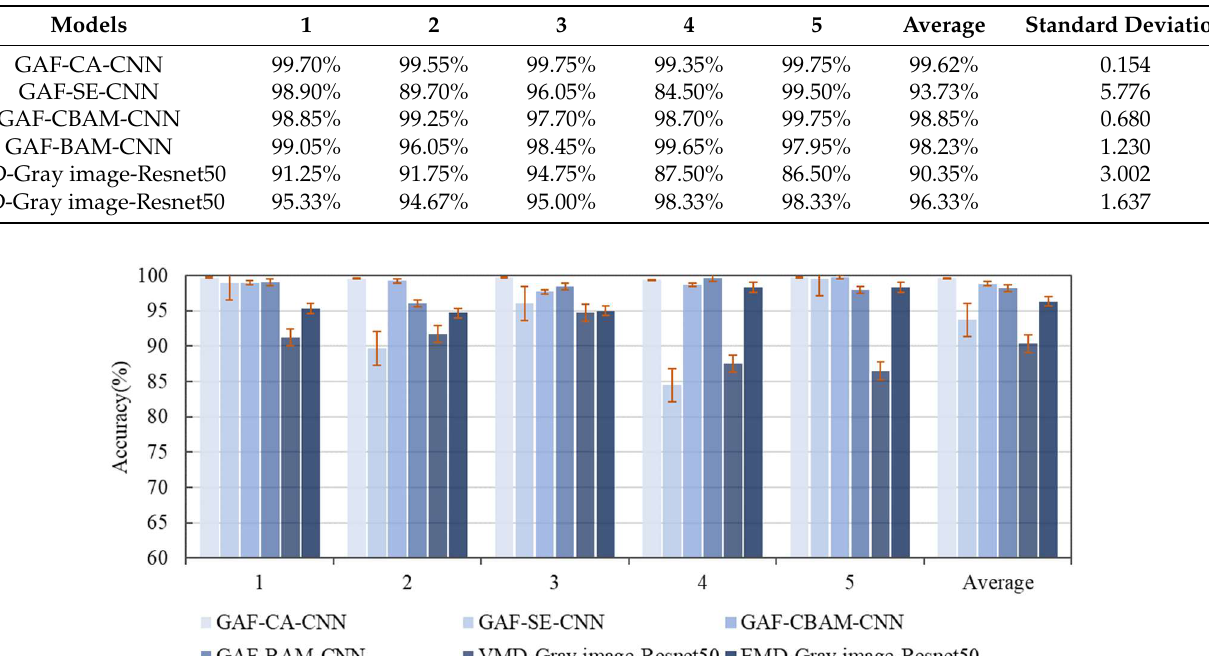
Table 5. Diagnostics result of different methods on Dataset A.